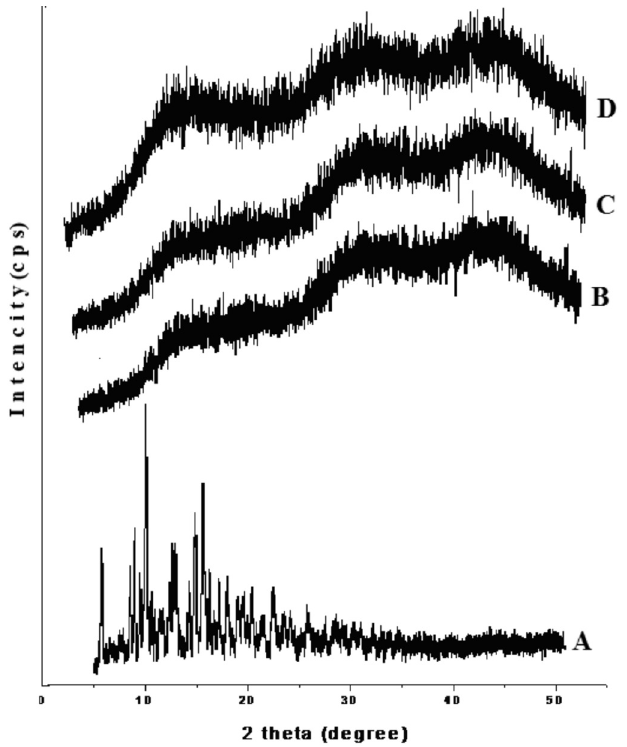
FIGURE 3 - X ray diffractogram of TMZ (A), Sodium alginate (B), TMZ-loaded beads prepared by sequential method(C), TMZ-loaded beads prepared by simultaneous method(D).